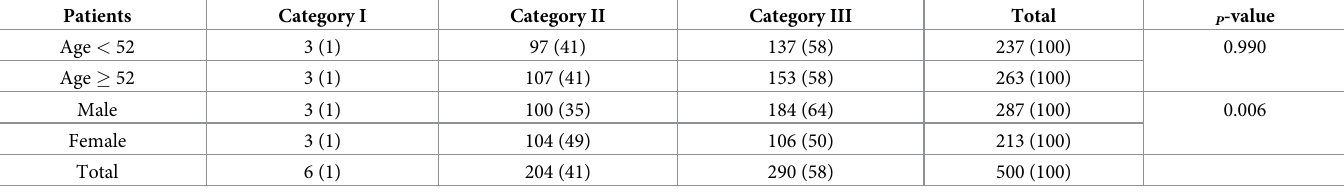
Table 3. Positive findings (n = 500) by age and